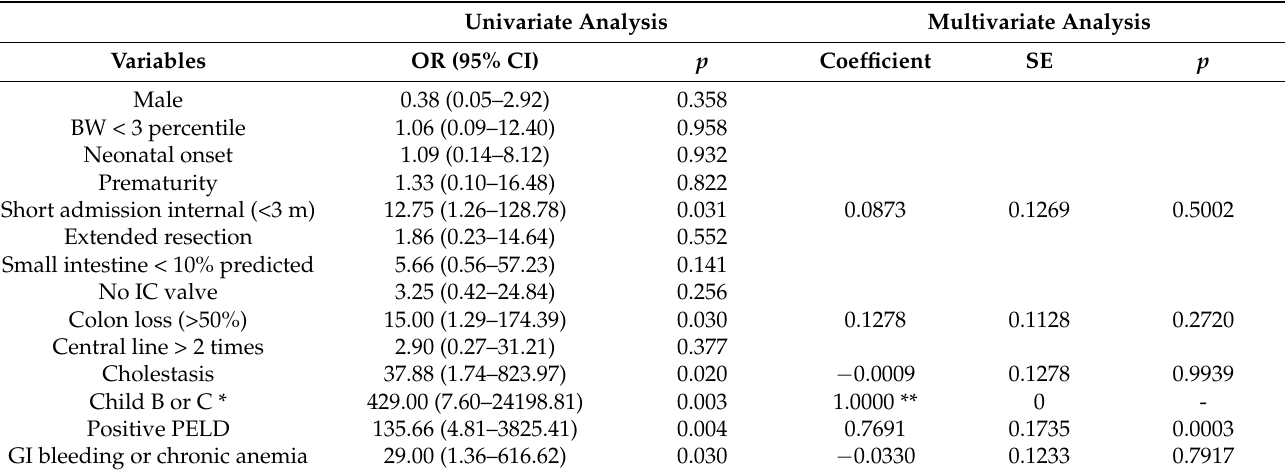
Table 7. Risk factor analysis for